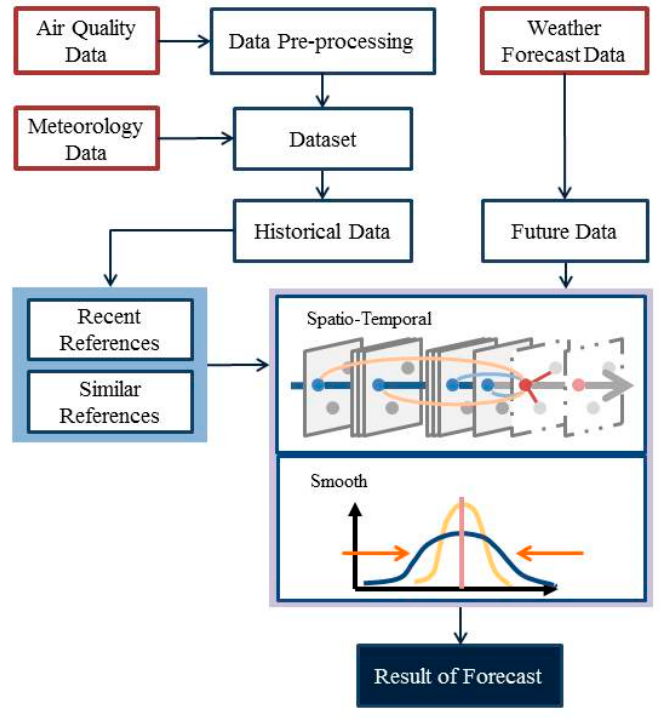
Figure 2. Framework of the spatial-temporal PM2.5 forecast approach.